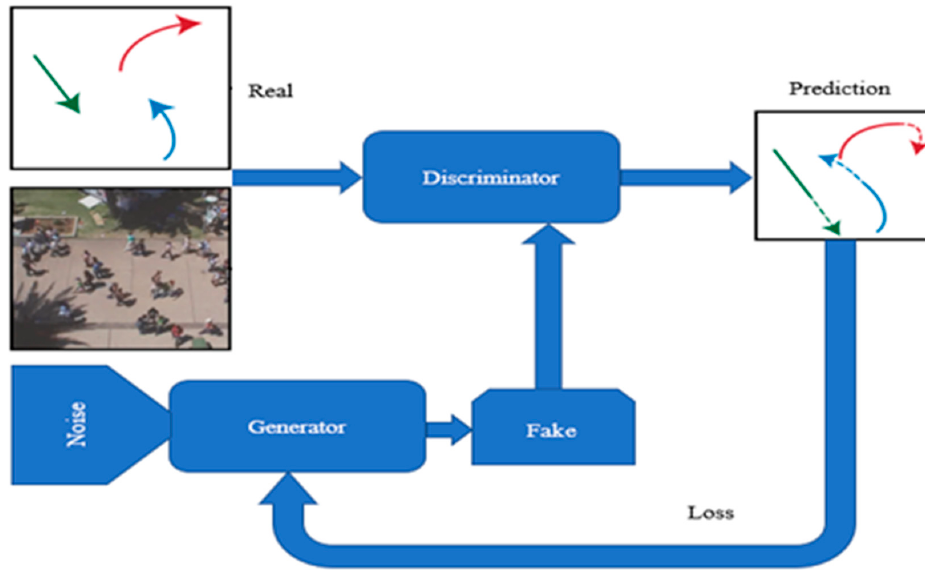
Figure 11. A typical GAN architecture for trajectory prediction.